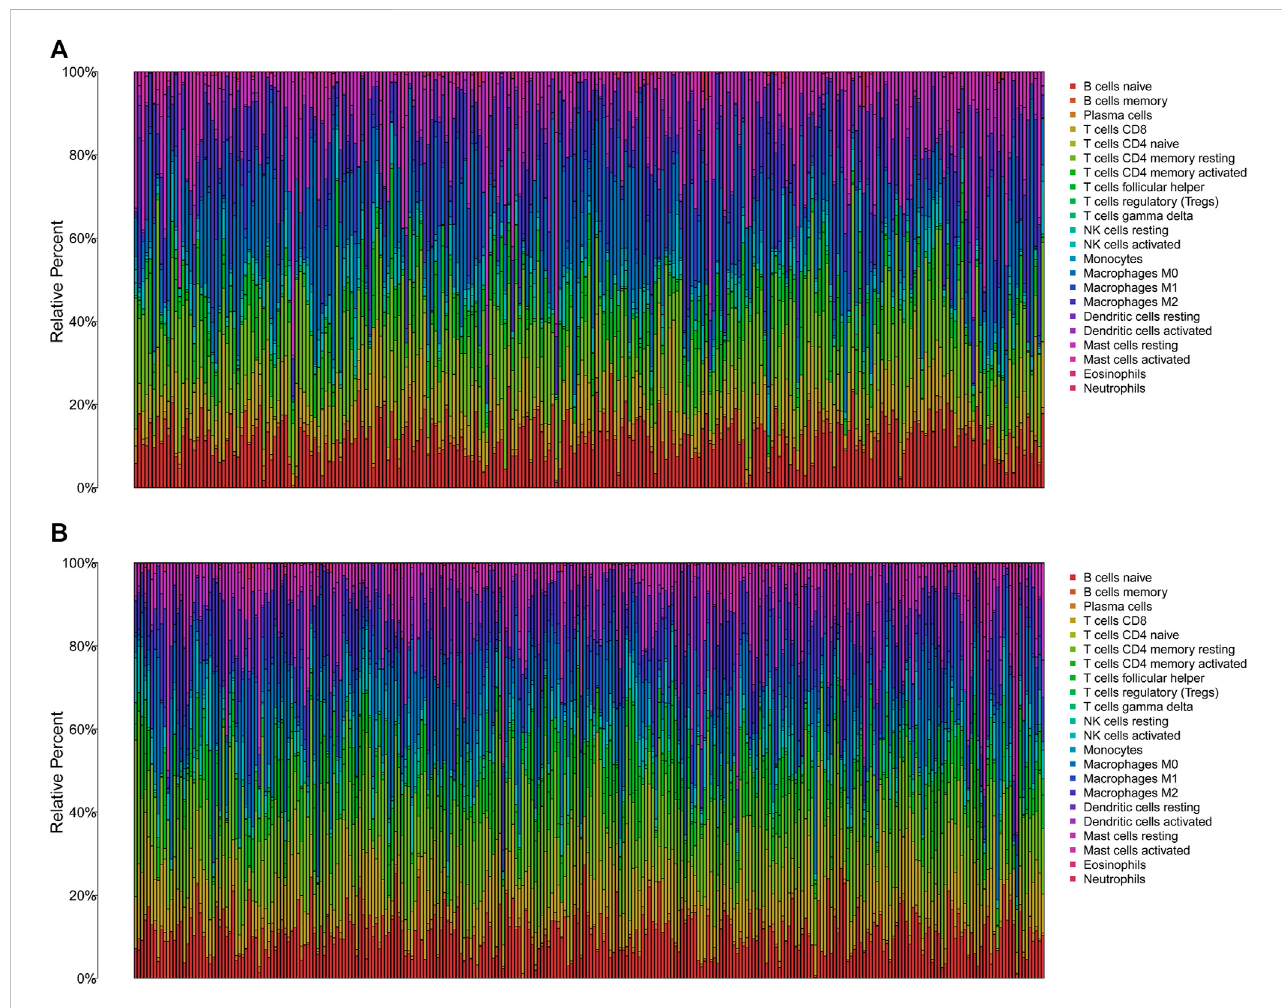
FIGURE 8 The immune in fi ltration of 22 immune cell types in high- and low-risk patients with BC. (A) The immune in fi ltration of 22 immune cell types in high-risk patients with BC. (B) The immune in fi ltration of 22 immune cell types in low-risk patients with BC. BC, breast cancer.